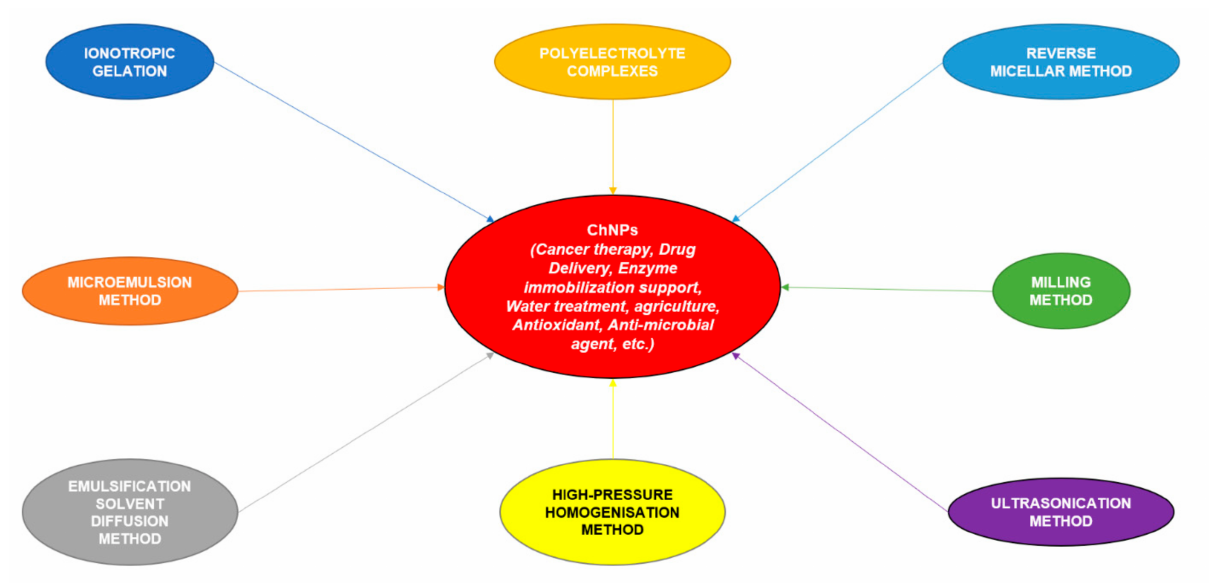
Figure 1. Schematic representation of the various methods employed for ChNP